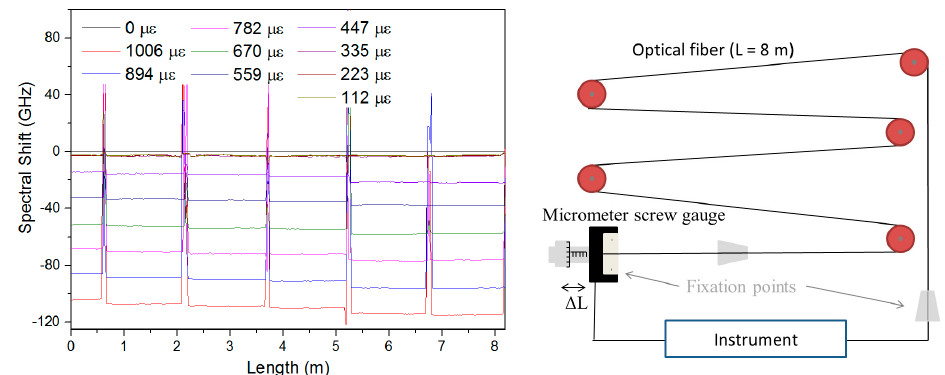
Figure 6. (Left) Example of distributed strain measurement obtained with TW-OTDR while a fibre is pulled at 10 different stress levels on the strain sensing bench (sketched on the right).